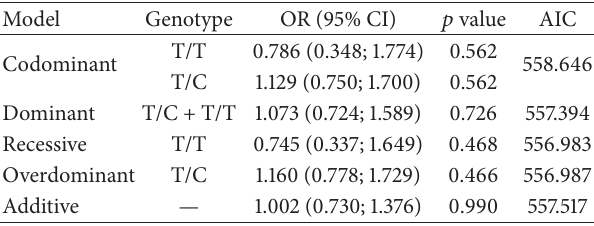
Table 8: Binomial logistic regression analysis of the CYP4F2 (1347C > T; V433M) rs2108622 in males and females with eAMD